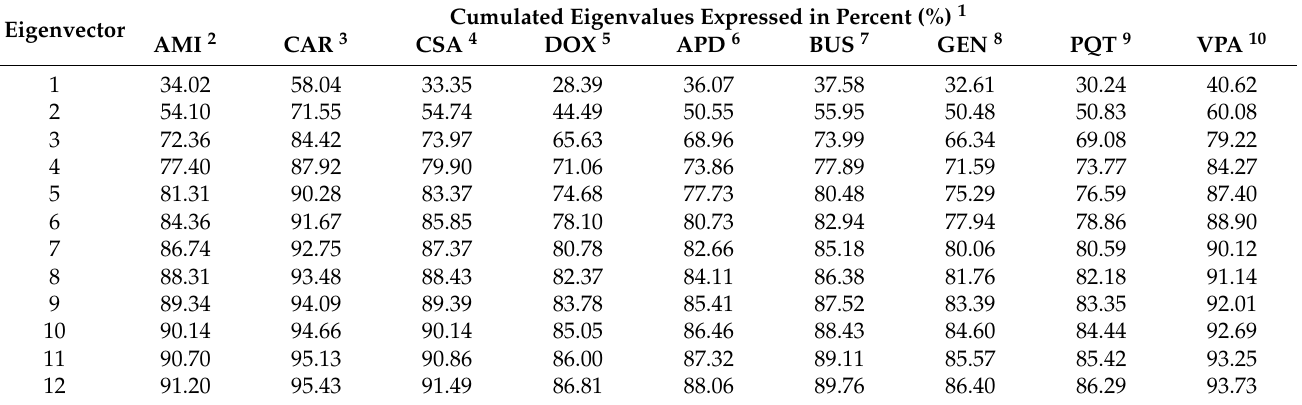
Table 2. PCA analysis for the 500 ns simulation run of P-gp ligand-bound systems.